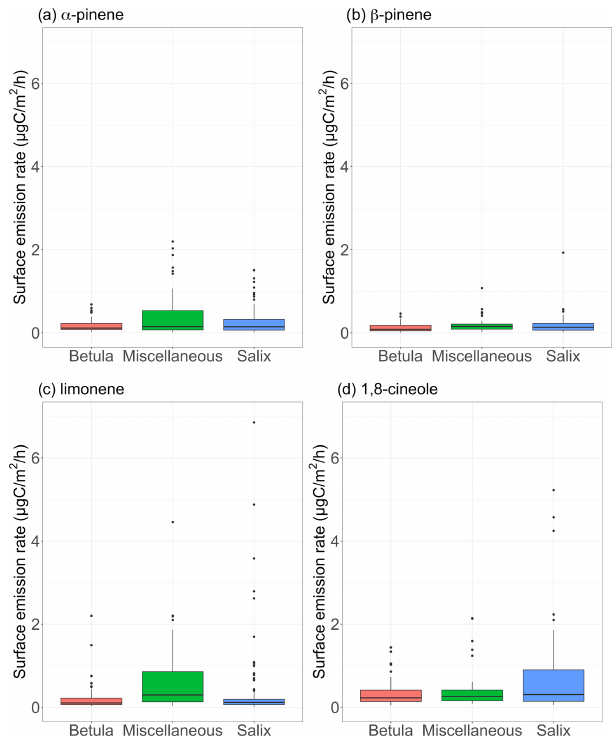
Figure 7. Surface emission rates of various monoterpenes (in µgCm − 2 h − 1 ) for different vegetation types. The lower and upper hinges correspond to the first and third quartiles. The upper (lower) whisker extends from the hinge to the largest (smallest) value no further than 1 . 5 × IQR from the hinge, where IQR is the interquartile range (i.e., the distance between the first and third quartiles). The √ n and give a ∼ 95% confidence inter- notches extend 1 . 58 × IQR / val for medians. Miscellaneous refers to a mix of different species, including lichens and moss